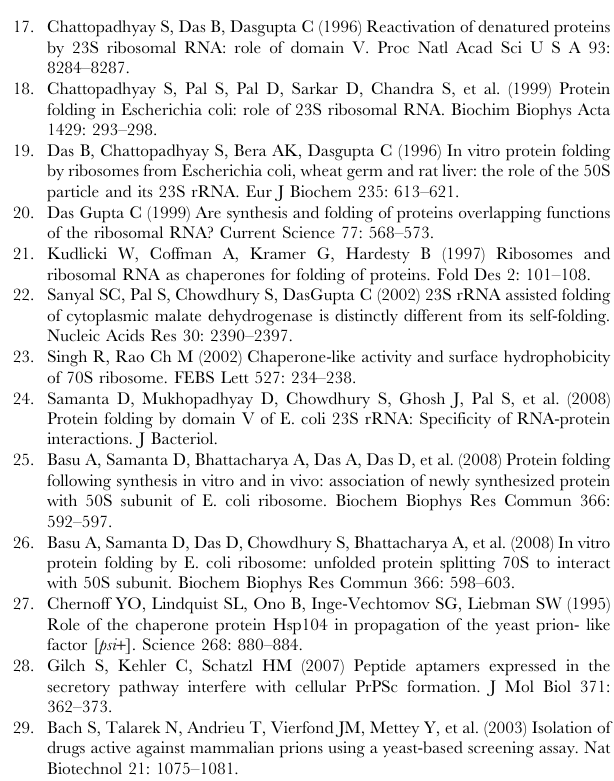
Figure S2 6AP and GA antiprion drugs do not inhibit protein synthesis. a - Effect of antiprion drugs on in vitro translation. The formation of f-Met-Leu dipeptide was assayed in an in vitro translation system based on purified E. coli ribosome in the presence of 1 mM of 6AP, 6APi, GA and GAi. None of the tested drugs showed a significant effect on the kinetics of translation. b